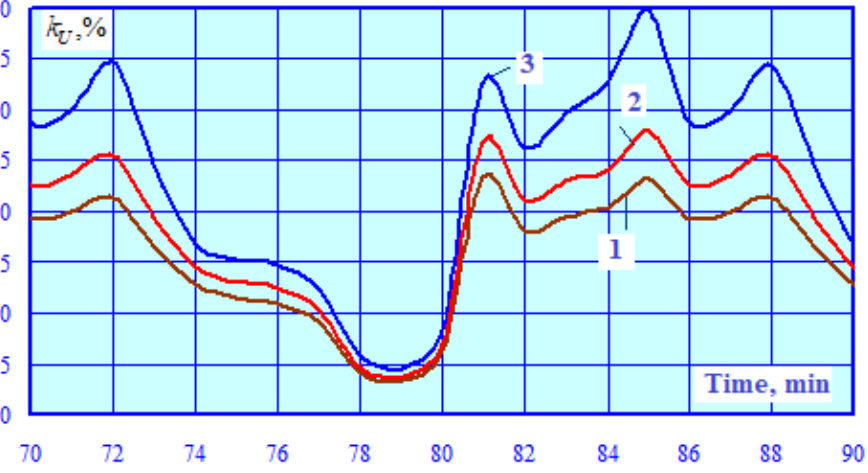
Figure 10. Total harmonic distortion values at the 27.5 kV input of TP 4—callout numbers correspond to those in Figure 6.